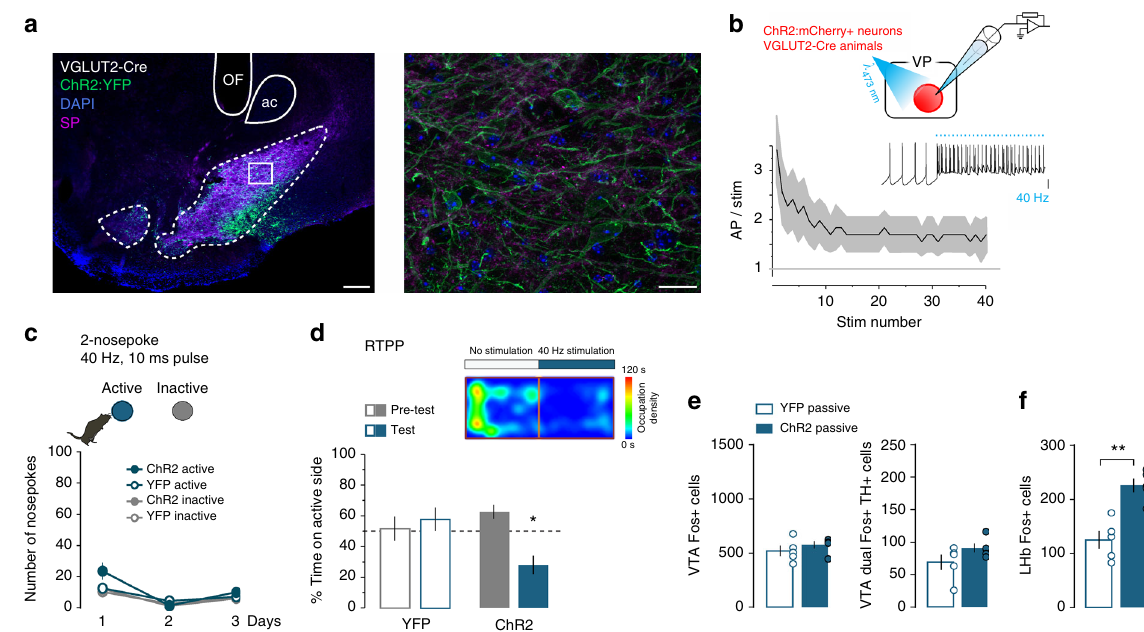
Fig. 4 Stimulation of VP glutamate neurons induces place avoidance. a Expression of ChR2:YFP in the VP of VGLUT2-Cre mouse imaged under wide fi eld (left, scale 200 µ m) or apotome (right, scale 20 µ m) illumination. b Action potential discharge of ChR2:mCherry + VP glutamate neuron in response to 40- Hz photostimulation ( n = 7 cells); SEM represented in gray. Inset shows representative trace; scale = 20 mV. c Over three daily 1-h two-nosepoke ICSS sessions, mice did not demonstrate robust self-stimulation for VP glutamate neurons ( n = 5 YFP controls, n = 6 ChR2). d VGLUT2-Cre mice avoided the compartment paired with photostimulation of VP glutamate neurons in the RTPP assay ( n = 5 YFP and ChR2 animals). Right panel shows occupation density of an example mouse during a test trial. e Passive activation of VP glutamate neurons failed to increase Fos + cell counts in the VTA ( n = 5). f However, the number of LHb cells positive for Fos increased following passive stimulation of VP glutamate neurons. * p < 0.05, ** p < 0.01, *** p <